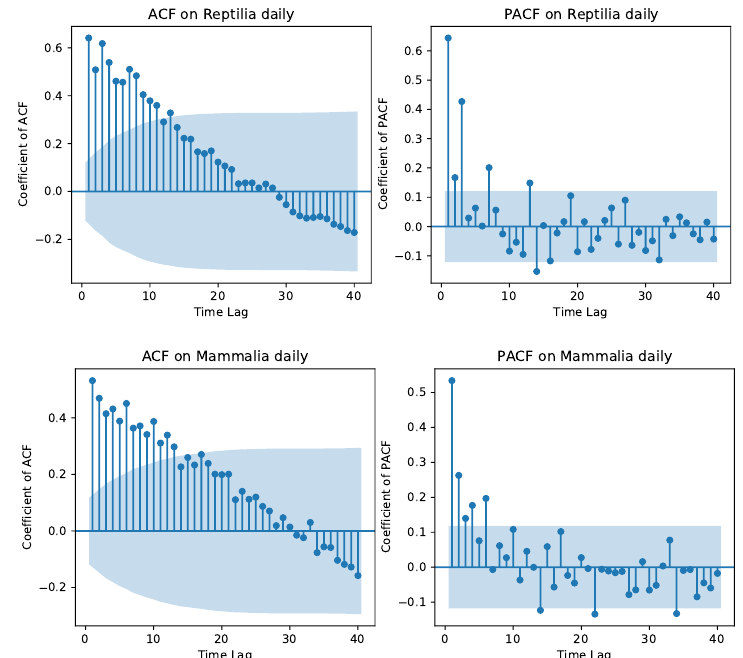
Figure 4. ACF (top-left panel) and PACF (top-right panel) on the Reptilia data showing stationarity. ACF (bottom-left panel) and PACF (bottom-right panel) on the Mammalia data showing stationarity on endogenous